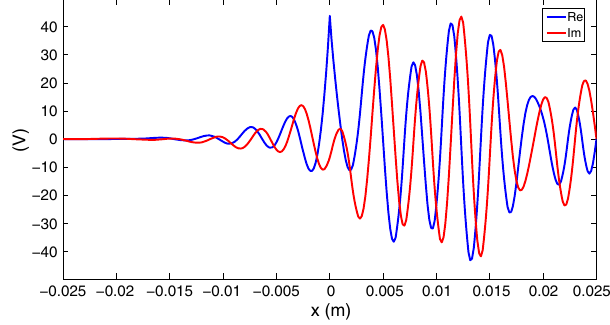
ˆ E k; s; x Þ at y ¼ g , at the end of yp ð